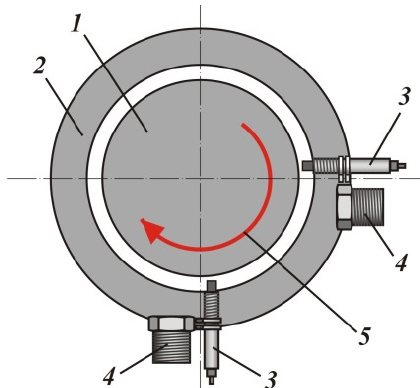
Figure 3. Contactless XY sensor installation scheme: 1—shaft of the hydraulic unit; 2—bearing housing; 3—non-contact sensor of relative radial vibration of the shaft; 4—vibration sensors of the bearing housing (accelerometer); 5—direction of rotation